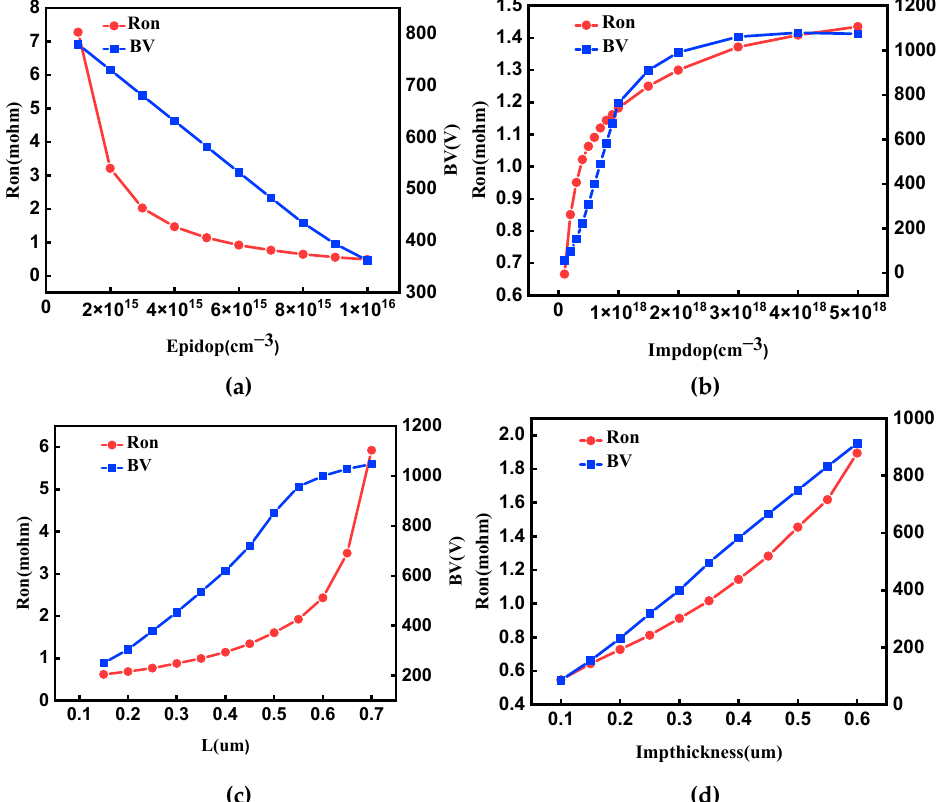
Figure 2. Ron and BV vary with different sensitive parameters, The corresponding sensitive parameters in Figure ( a – d ) are, respectively, doping concentration in drift region (Epidop), doping concentration in P+ region (Impdop), a ratio of the width of P+ region to the spacing between adjacent P+ region (defined by parameter L), and injection depth of P+ region (Impthickness). Table 2. The control group of each sensitive parameter in the sample data.